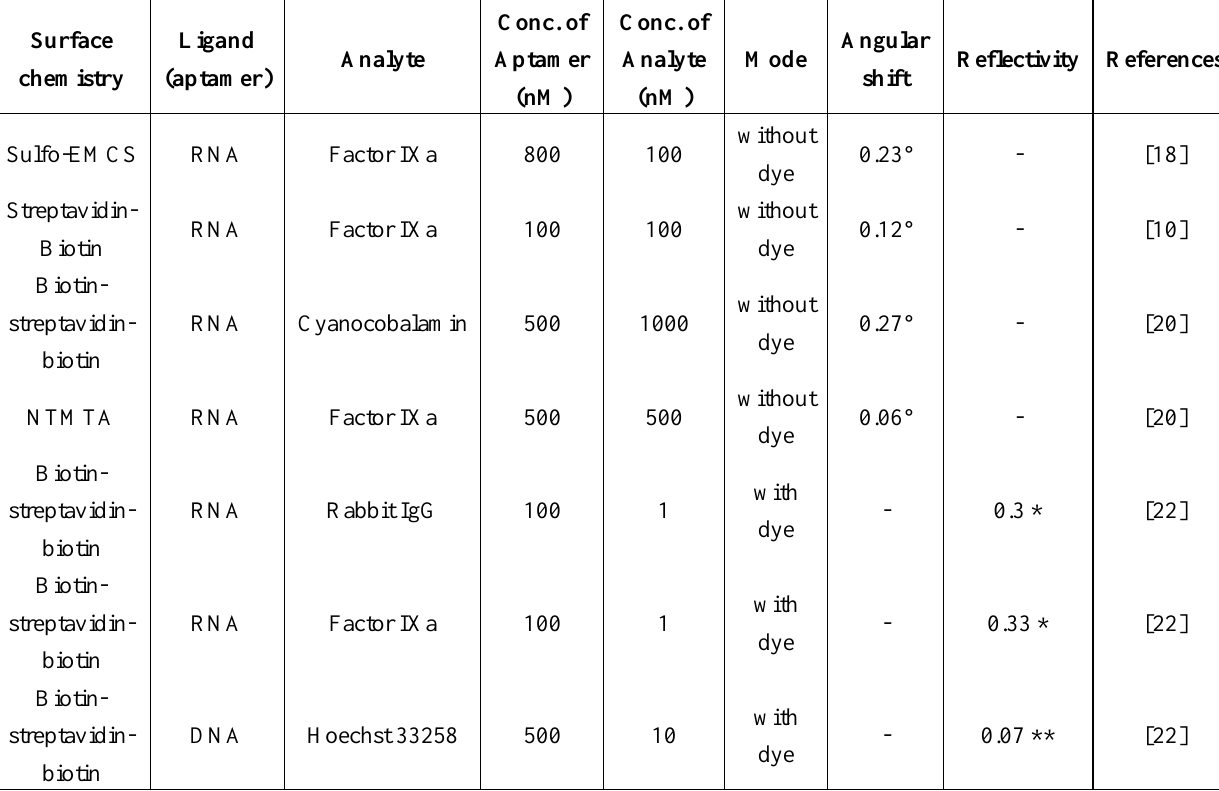
Table 1. Aptamer recognitions on waveguide-mode